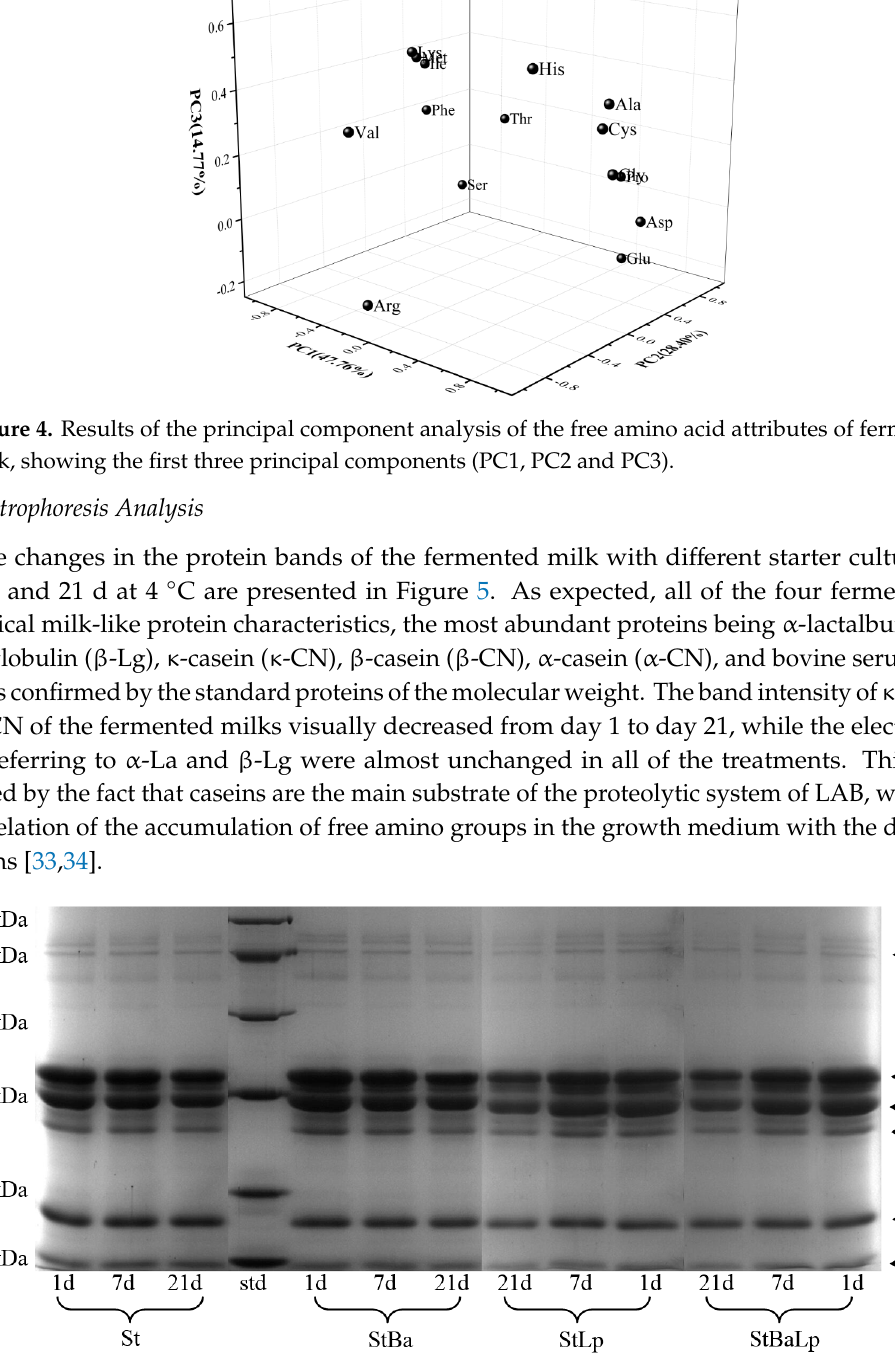
Figure 5. Electrophoretogram of fermented milk from different starter cultures during 21-day storage at 4 °C. Note: std (standard of molecular weight).